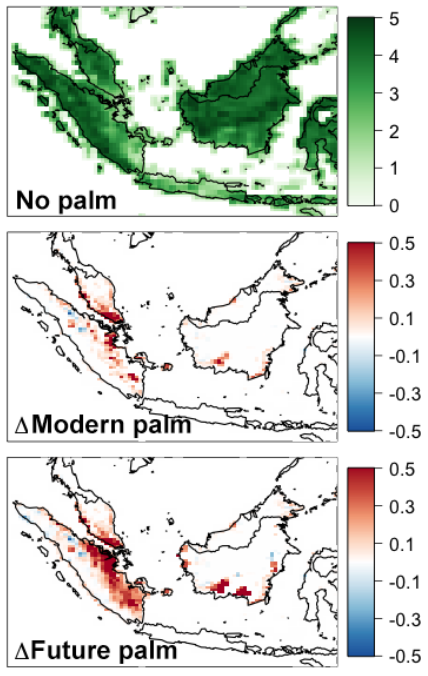
Figure 5. Annual average leaf area index (LAI) over SEA (top) and the change due to Modern (middle) and Future (bottom) palm ex-